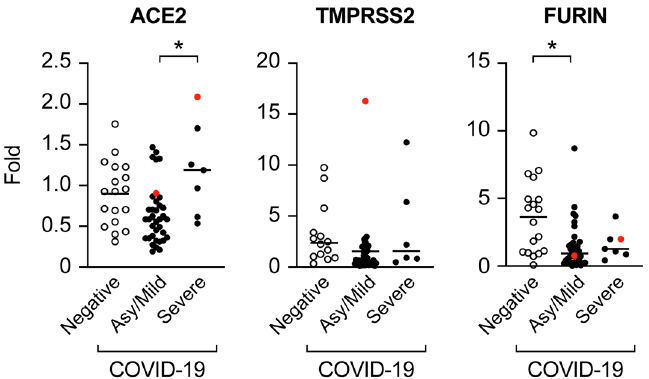
Figure 3. Placental expression of mRNAs for SARS-CoV-2 entry proteins. Analysis, stratified by disease severity (asymptomatic/mild vs severe) and negative controls, was performed using RT-qPCR as detailed in “Methods”. The red dot denotes SARS-CoV-2-positive placenta. The data were analyzed using the Kruskal– Wallis nonparametric test, with post hoc Tukey test for all pairwise comparisons. *Denotes p <